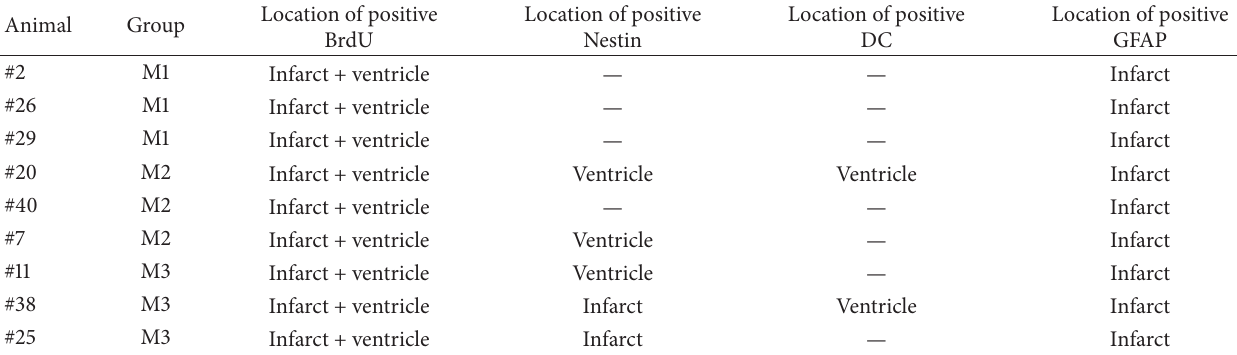
Table 2: Histopathological findings.